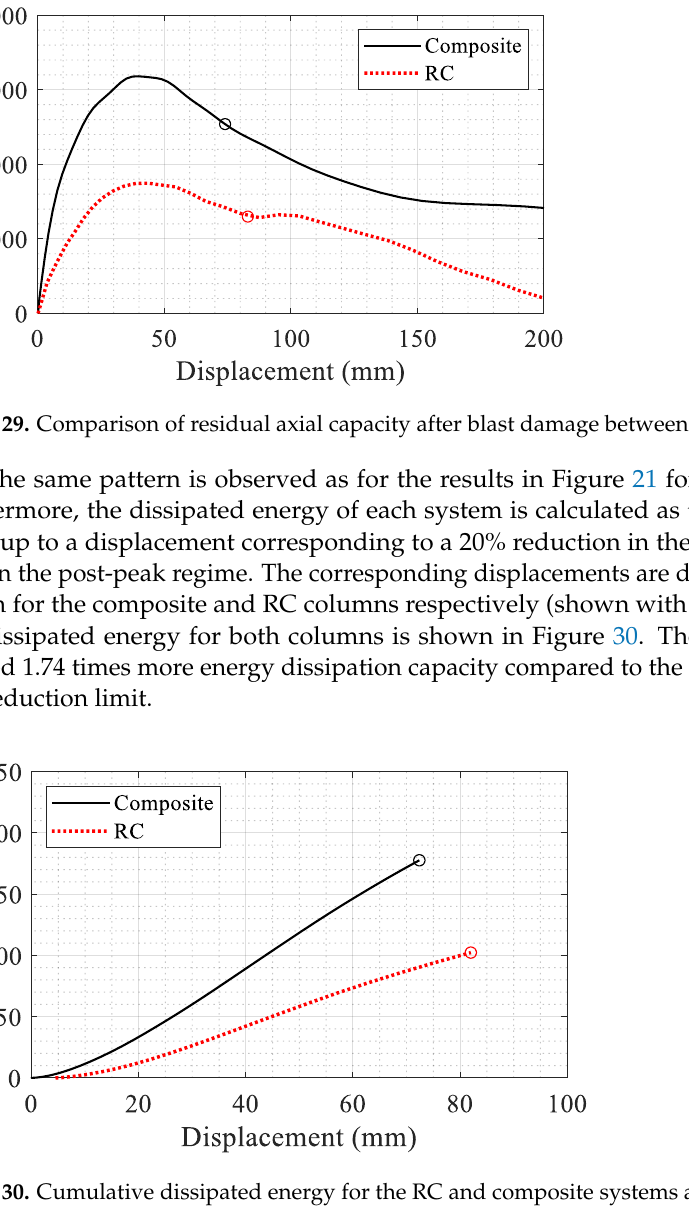
Figure 30. Cumulative dissipated energy for the RC and composite systems after blast damage.